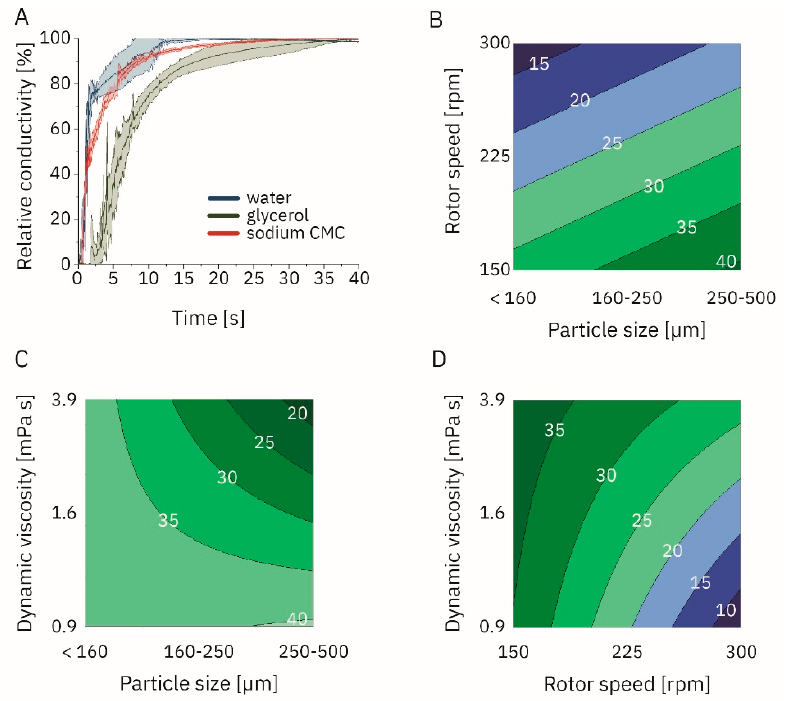
Figure 3. ( A ) Time series of the relative conductivity for the dissolution of monobasic sodium hydrogen phosphate dihydrate in a mixing vessel the size of a multi-dose autoinjector at 300 rpm and particle size <160 µm (this is introduced in Figure 1B). Effects of ( B ) rotor speed and particle size, ( C ) dynamic viscosity and particle size, ( D ) dynamic viscosity and rotor speed on the dissolution time as indicated by white numbers and in s.